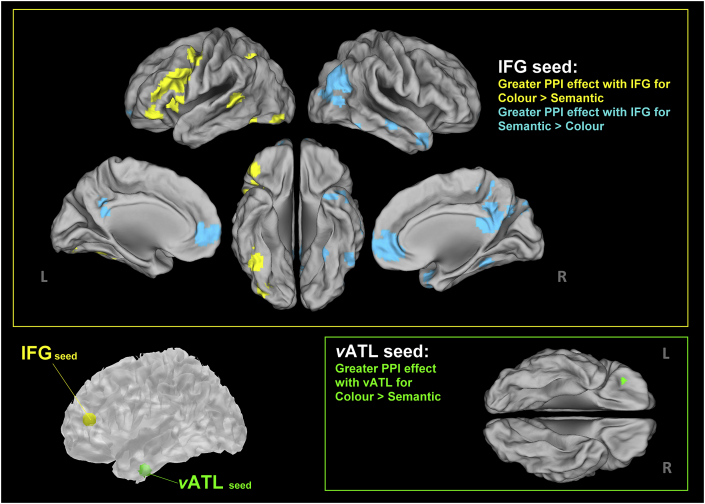
Results of the PPI analysis, thresholded at p < .005 for voxel intensity and furthered constrained for cluster size (extending at least 270 mm3). Yellow: significantly greater functional connectivity (the PPI effect) with the left IFG seed for arbitrary pairing by canonical colour. Cyan: significant PPI effect with the left IFG for semantic pairing by meaning. Green: significant PPI effect with the left ventral ATL seed for colour pairing.